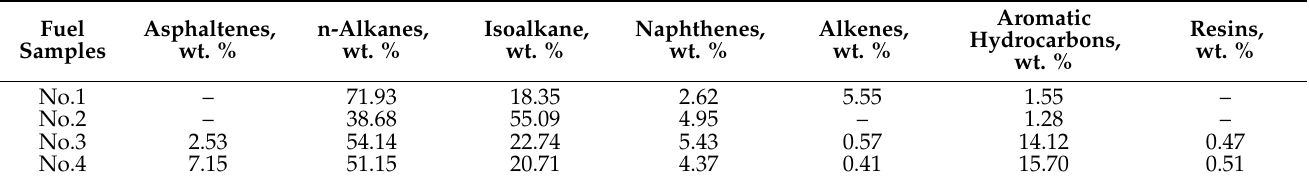
Table 2. Analysis of the hydrocarbon group composition of fuel